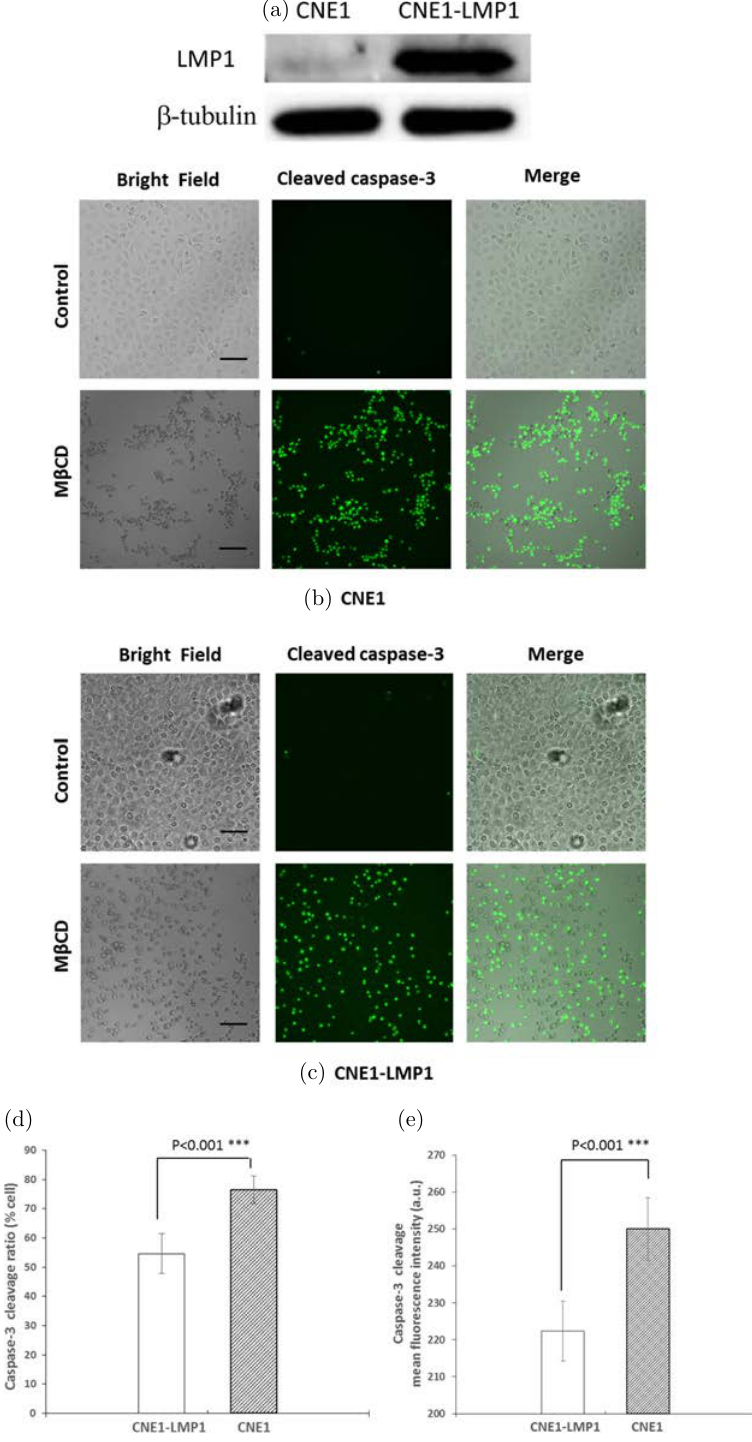
Fig. 2. Induction of apoptosis in NPC cells by M (cid:1) CD treatment. (a) Expression of LMP1 protein in CNE1 and CNE1-LMP1 cells were measured by western blotting. (b) CNE1 cells were treated with 40 mM M (cid:1) CD for 30 min. (c) CNE1-LMP1 cells were treated with 40 mM M (cid:1) CD for 30 min. (d) Di®erences of caspase-3 cleavage ratio between CNE1 and CNE1-LMP1 cells. (e) Di®erences of mean °uorescence intensity induced by caspase-3 cleavage between CNE1 and CNE1-LMP1 cells. Corresponding statistical results from at least 4000 cells. These images were representative of three independent experiments. Scale bar, 100 (cid:2)